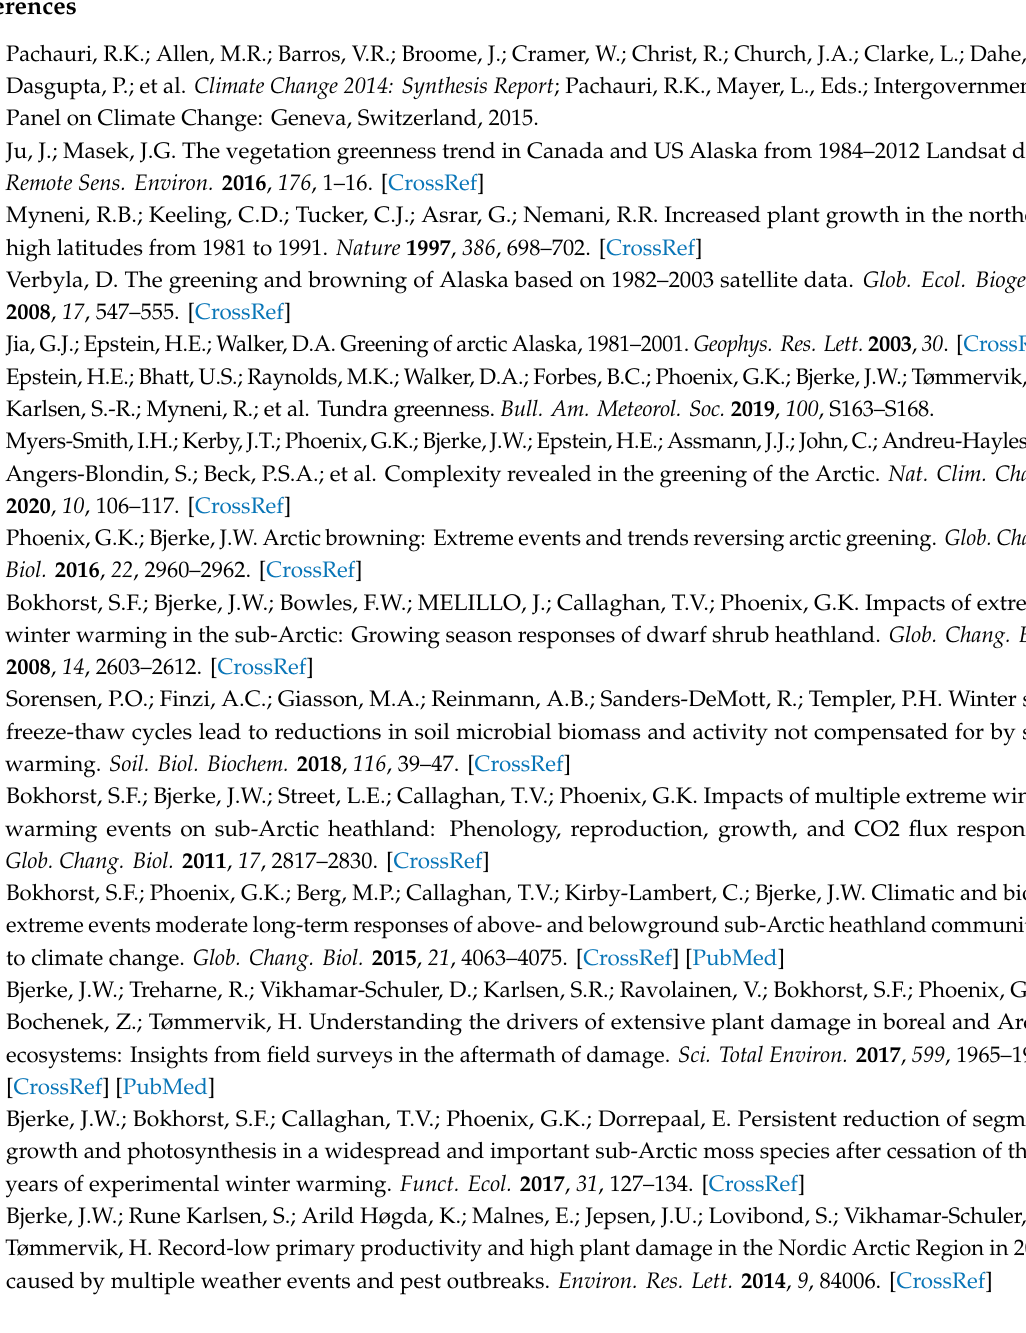
while significance is two-tailed., Table S7: Correlation table for plots dominated by Hylocomium splendens . Correlations are computed by Pearson’s correlation, while significance is two-tailed. Table S8: Correlation table for mixed plots of Empetrum nigrum and Hylocomium splendens . Correlations are computed by Pearson’s correlation, while significance is